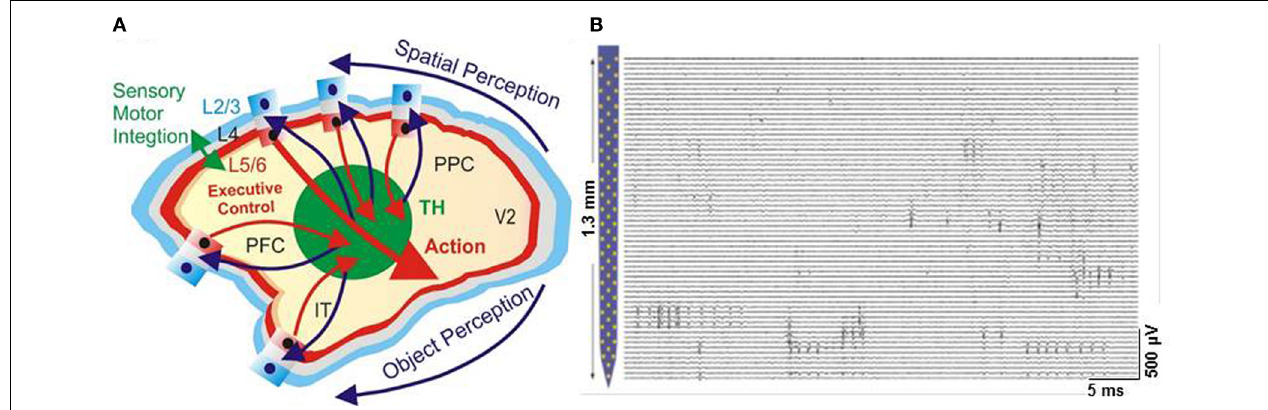
FIGURE 9 | Cortical modularity and parallel recording capabilities of the multiplexed neurophysiological system. (A) Cortical modularity showing laminar anc columnar arrangements of neurons in the primate neocortex (L2/3 is layer 2/3, L5/6, layer 5/6, V2, visual